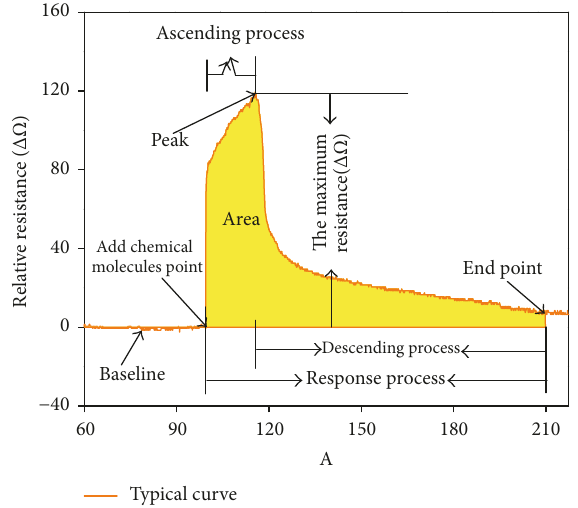
Figure 3: The GFCS typical response resistance